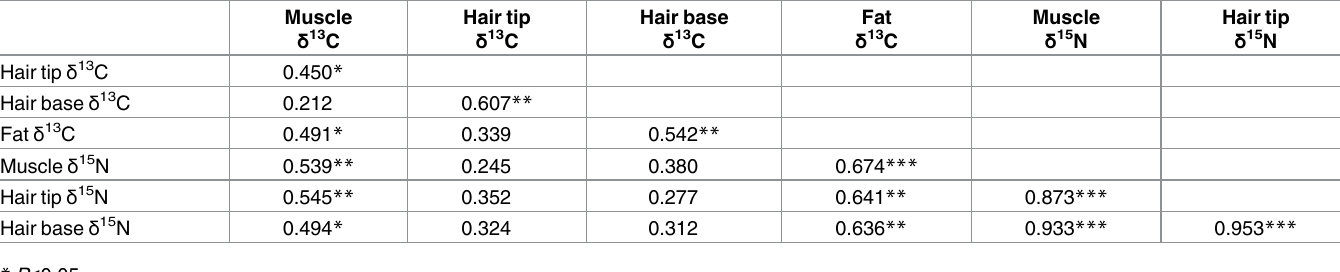
Table 5. Correlations among δ 13 C and δ 15 N in different sample types of free-living wild boar harvested in different